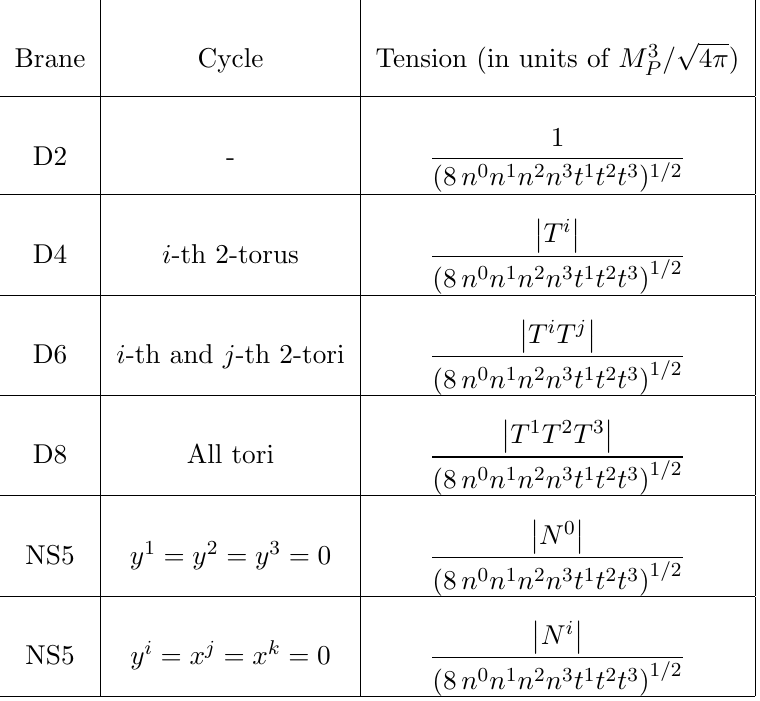
Table 2. Tensions of the basis of domain walls obtained from D p or NS5-branes around the di(cid:11)erent ( p (cid:0) 2)-cycles or 3-cyles of the T 6 = Z 2 (cid:2) Z 0 , respectively. Note that i 6 = j 6 = k 6 = i 2